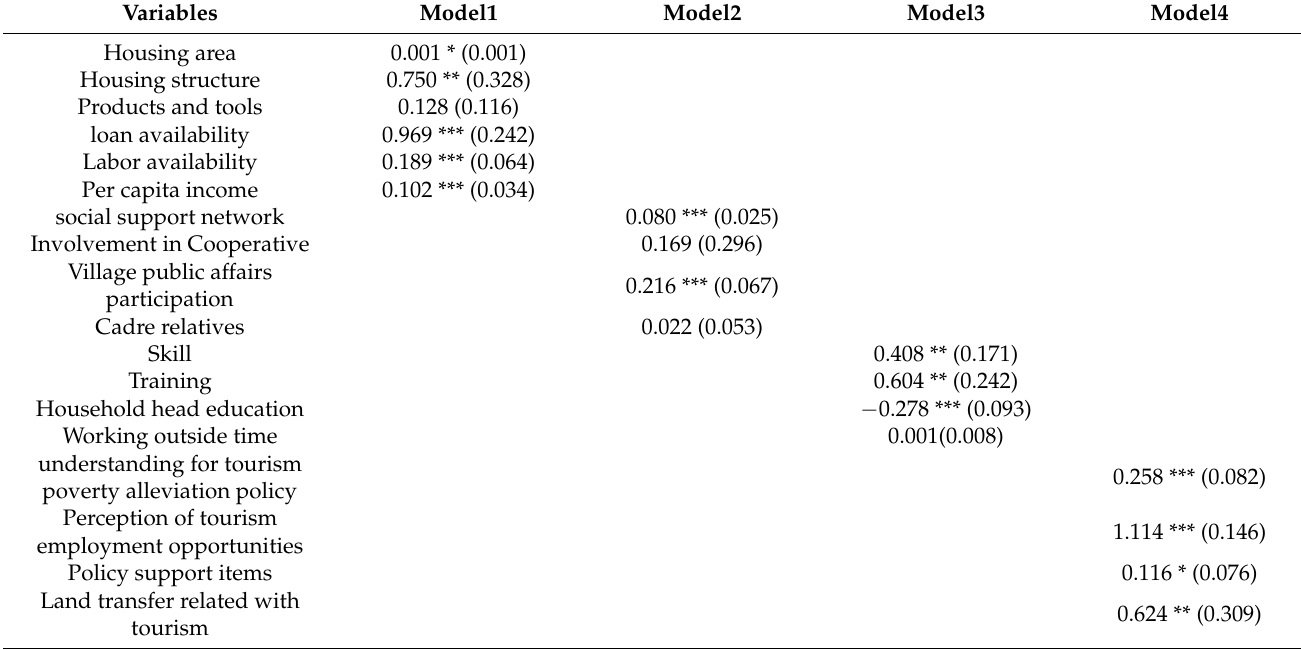
Table 4. The regression estimates of willingness to participate in tourism for rural households in sub-indicators (total